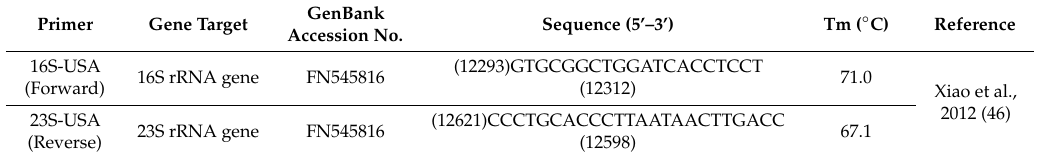
Table 1. Primer pair used for in silico PCR-based ribotyping of Clostridioides di ffi cile .